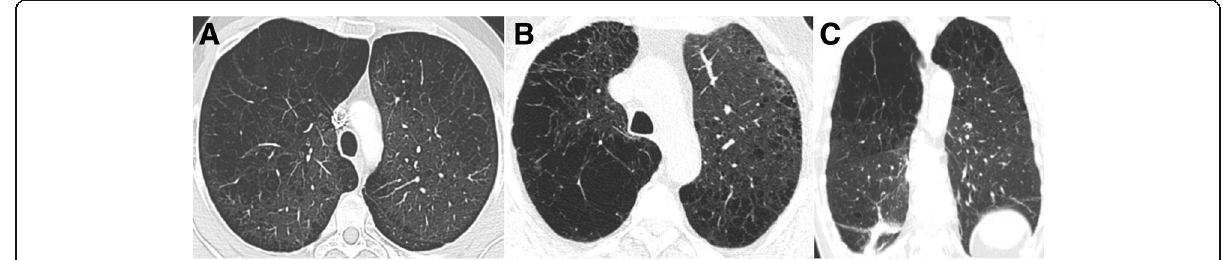
Fig. 5 Subtypes of severe CLE according to the Fleischner Society guidelines on HRCT. a Axial CT image depicts confluent CLE with coalescent centrilobular lucencies without significant distortion of the pulmonary architecture. b Axial and c coronal images show ADE, with panlobular lucencies, distortion of the underlying pulmonary architecture, and hyperexpansion of the lung